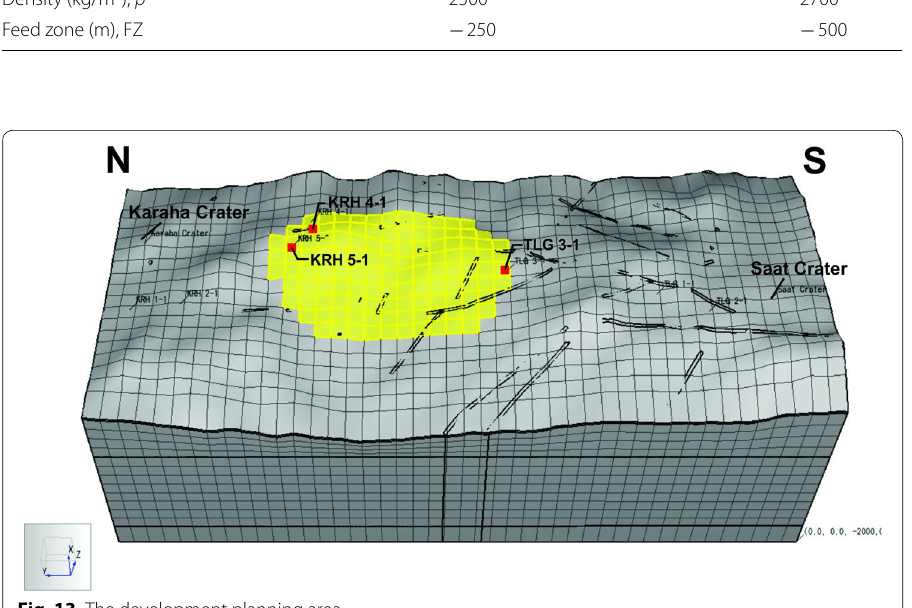
Fig. 13 The development planning